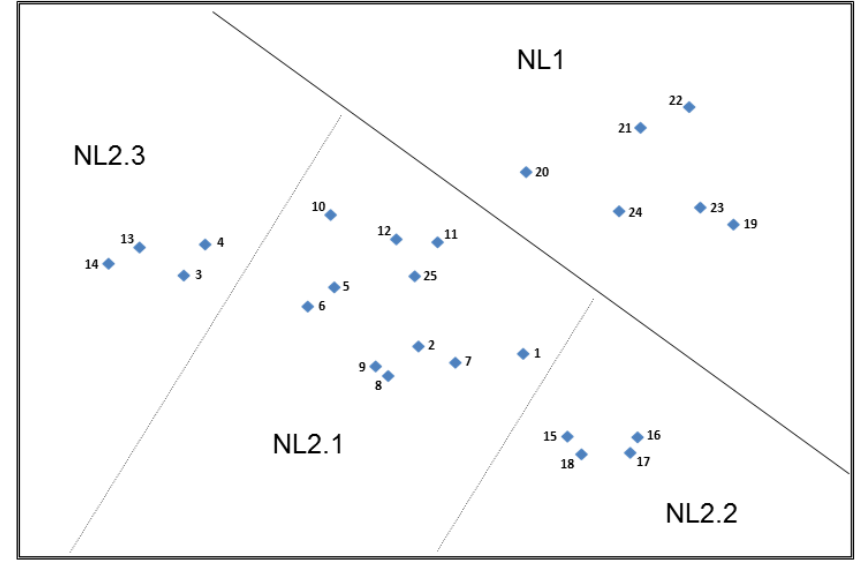
Figure 4. MSA Top Plot—The Netherlands (NL). See Table 2 for the claims associated with the stimuli card